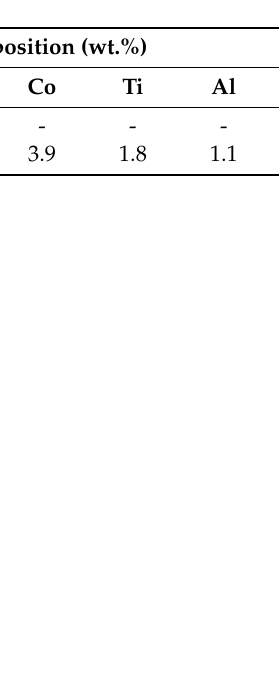
Figure 2. SEM (scanning electron microscope) images of feedstock powders. ( a ) Maraging, ( b ) Dy- comet 1008, ( c ) WC-12Co, ( d ) WC-10Co4Cr. Table 2. CGS feedstock material chemical compositions.